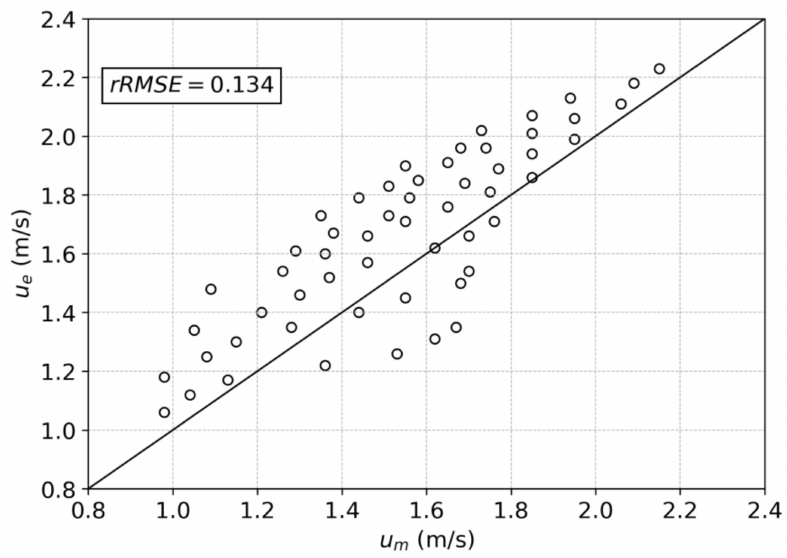
Figure 7. Comparisons of the measured and estimated OFV for c A , u = 1.3 and γ f = 0.38 with rRMSE = 0.134 and R 2 =